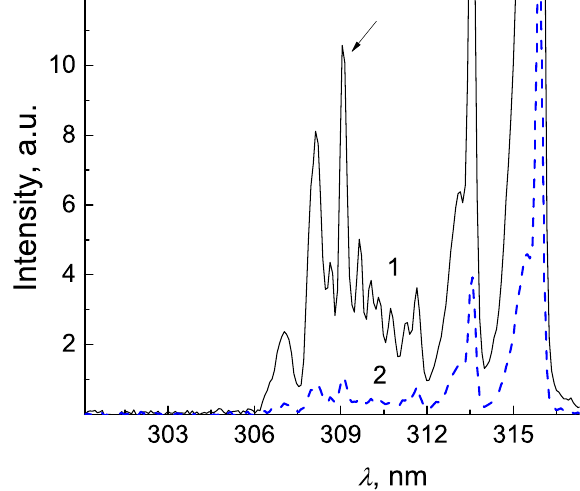
Figure 5. Part of spectrum with of OH peaks measured with the presence of the grounded substrate (1) and without it (2). An arrow indicates the peak at λ = 309 nm, helium, U = 4.9 kV, v = 3 L/min.